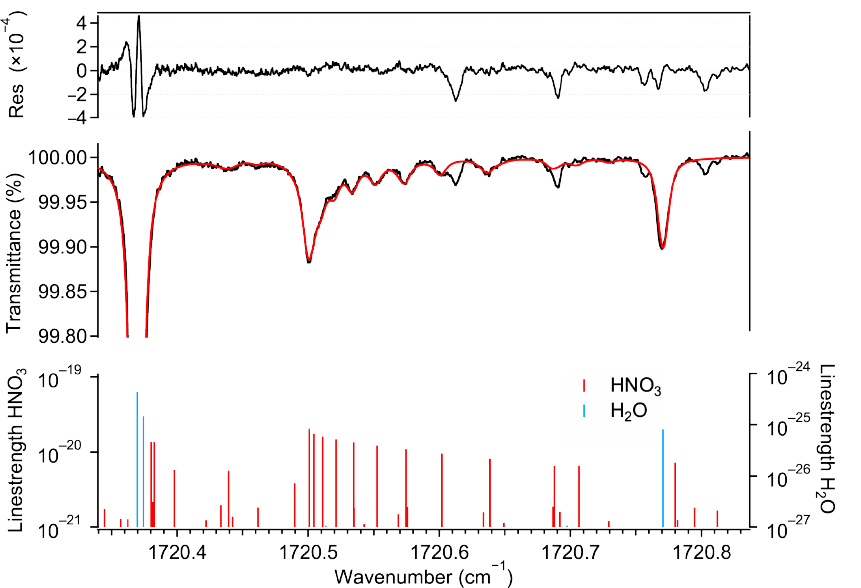
Figure 1. Bottom : ro-vibrational transitions of HNO and H O taken from HITRAN2020 [32]. 3 2 Middle : measured transmission spectrum (black) of a gas mixture (30°C, 5 kPa) of ambient air and HNO -containing air and the associated spectral fit using the Voigt profile (red). The retrieved 3 amount fraction corresponds to 12ppb HNO and 1.6% H O, respectively. Top : fit residual indicating 3 2 the quality of the fit (root mean square of the fringe level of 2.5 × 10 − 5 ) and the existence of some absorption features that could not be associated with any known transition listed in